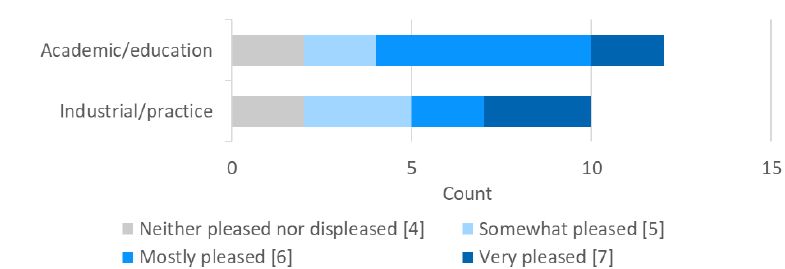
Figure 13. Respondent satisfaction with the way they approach design on 7-point scale, broken down by industry.